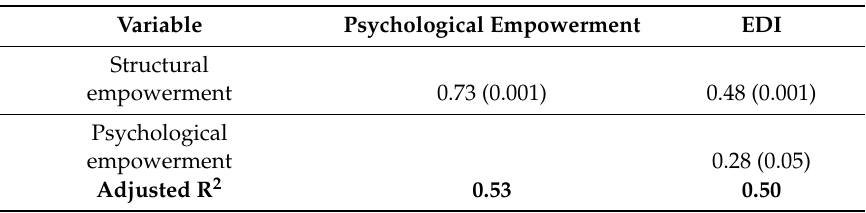
Table 5. Model - Standardized path coe ffi